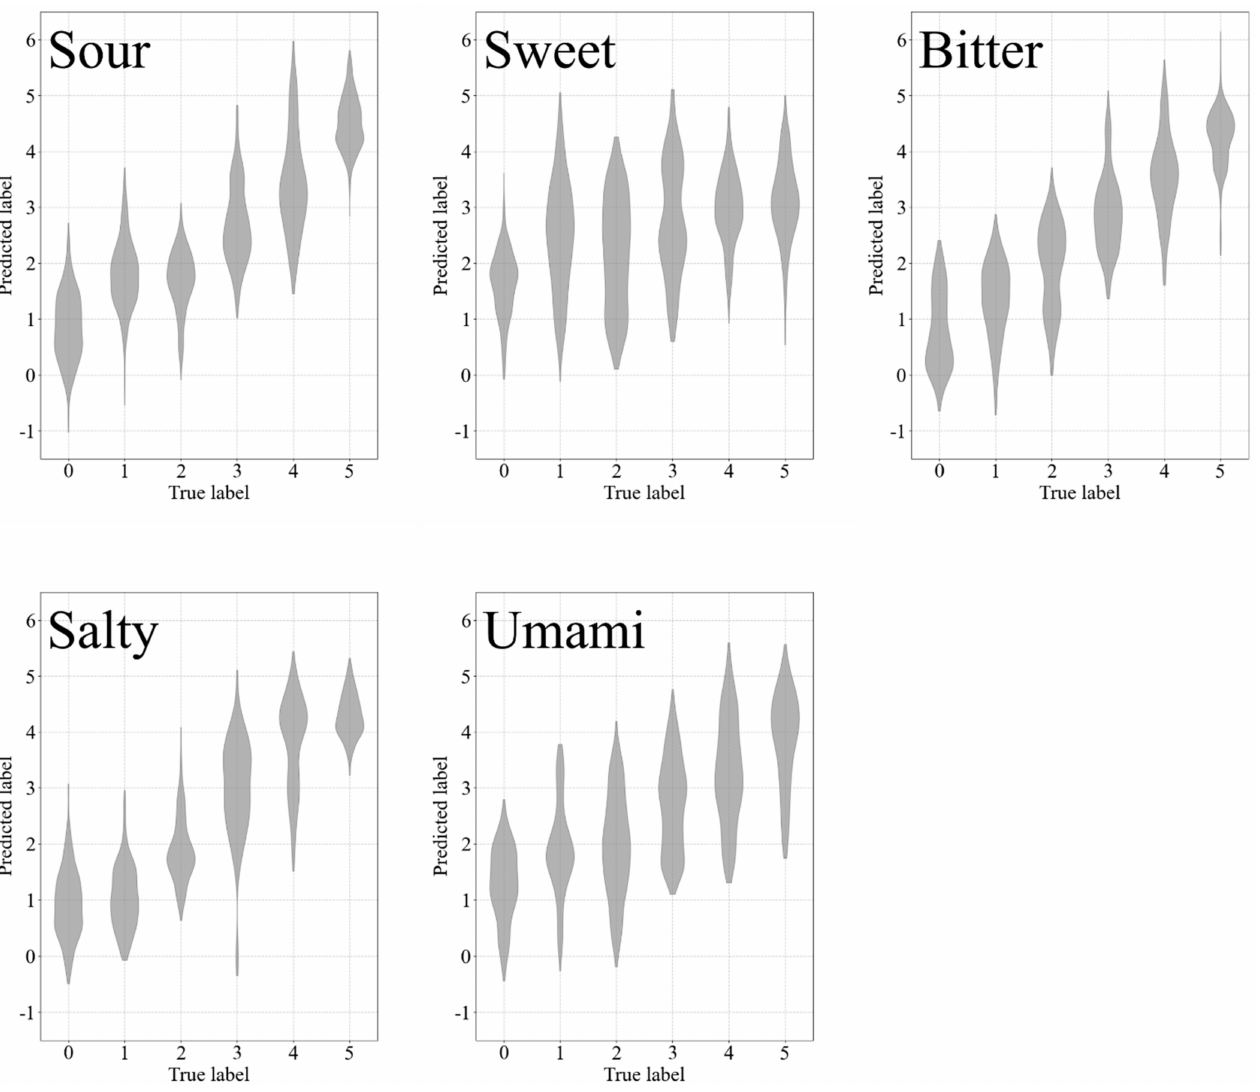
Figure 5. Regression results. The regression result for each primary taste type is shown with a violin plot and the width of the shape is the density of data points. The abscissa coordinate is the true strength label, and the vertical coordinate is the predicted strength